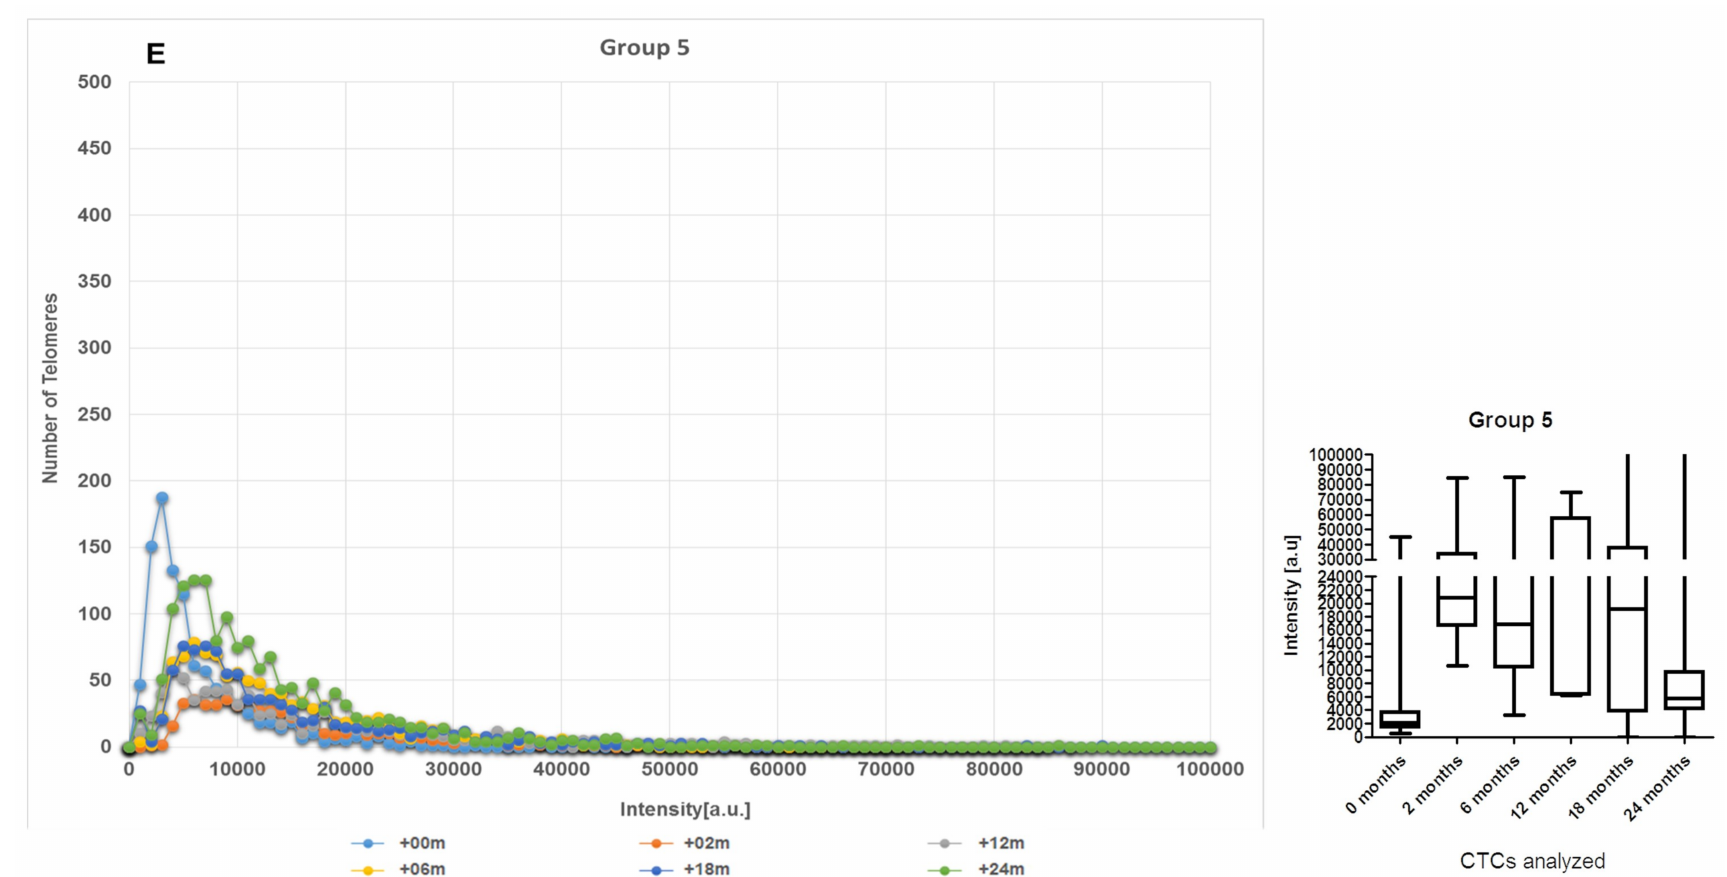
Figure 3. ( A ) Representative examples of the CTCs dynamics of telomere length profiles over time for patients assigned to Group 1 ( A ), Group 2 ( B ), Group 3 ( C ), Group 4 ( D ), and Group 5 ( E ). In each graph, the telomere length is shown in arbitrary units of fluorescence (AU). Baseline profile ( + 0 month, untreated) and other time point (2, 6, 12, 18, 24 months) are demarked with colors. Bars plot were used to illustrate inter-sample variability of representative individual samples in the